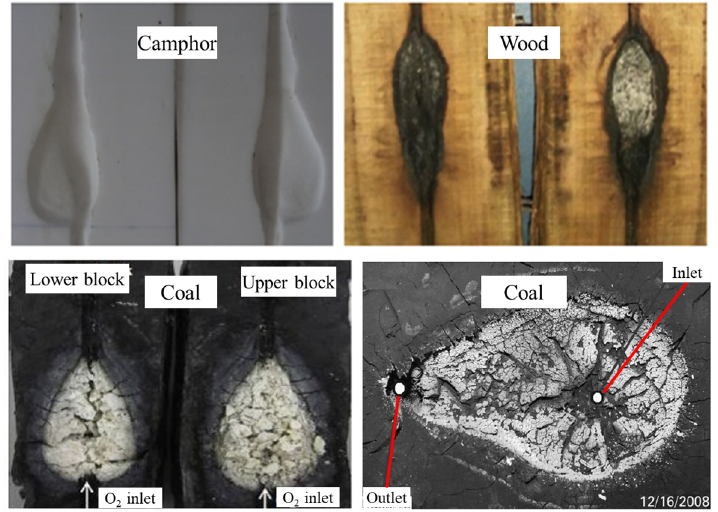
Figure 1. Cavity morphologies produced by gasification processes simulated with different materi- als.